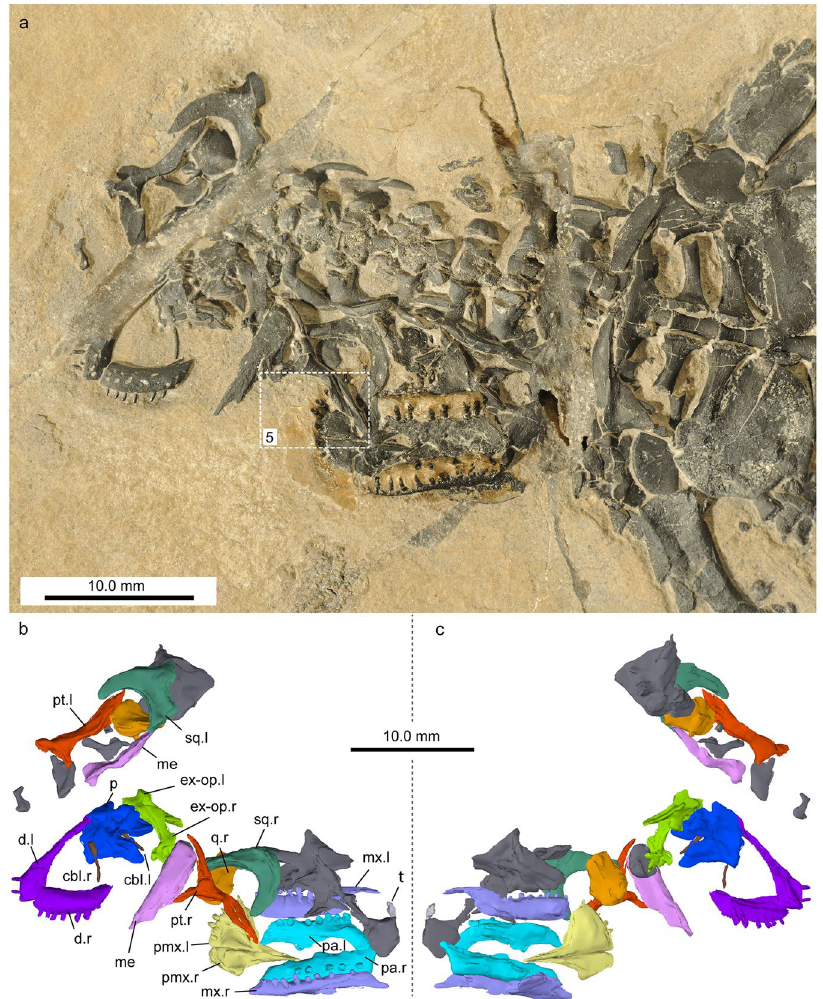
Figure 4. Skull and lower jaw elements of Eusaurosphargis dalsassoi (PIMUZ A/III 4380) in ventral view. ( a ) Photograph. White rectangle indicates section of skull shown in Fig. 5. ( b , c ) Virtual reconstruction of the cranial bones in ventral ( b ) and dorsal ( c ) view. Unidentified bones are shown in dark grey. Note that when possible the left (.l) and right (.r) side is indicated for the identified elements. Abbreviations used in the figure are ceratobranchial I (cbI), dentary (d), exoccipital-opisthotic (ex-op), mandible element (me), maxilla (mx), parietals (p), palatine (pa), premaxilla (pmx), pterygoid (pt), quadrate (q), squamosal (sq), and tooth